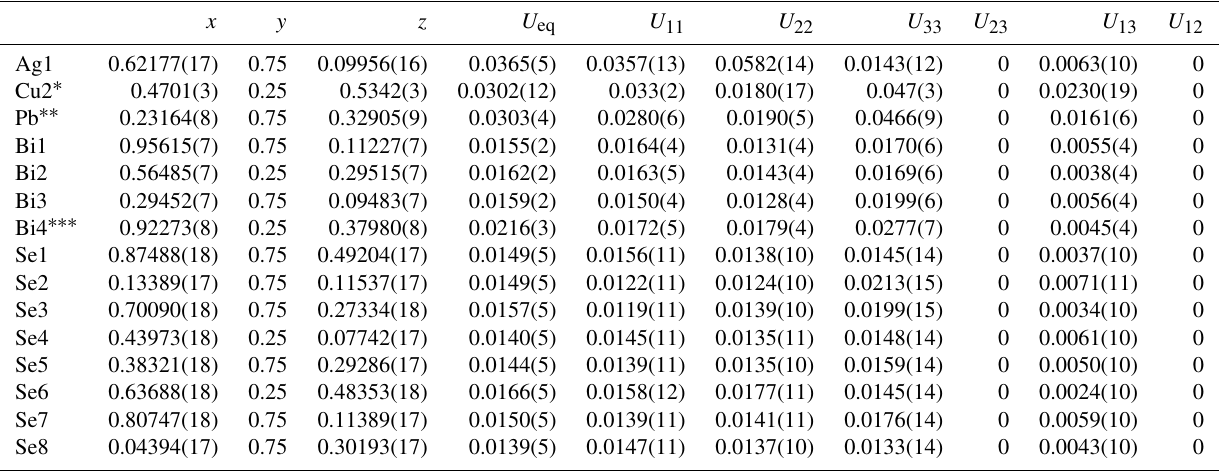
Table 4. Atom coordinates and anisotropic displacement parameters (Å 2 ) for luxembourgite from Bivels, Luxembourg.